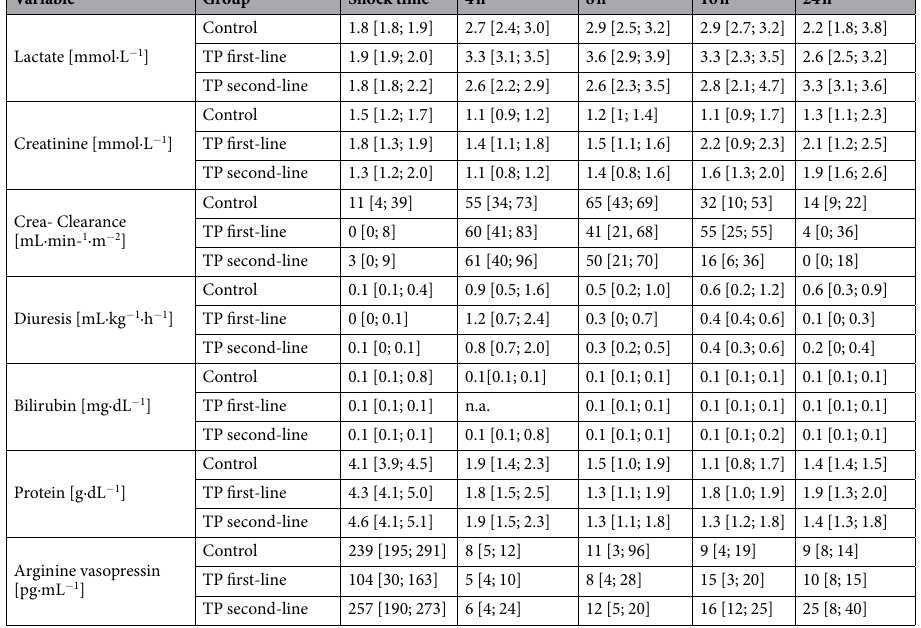
Table 3. Parameters of organ function of the study groups during the 24-hour interventional period. Values are presented as median [interquartile range]. Bilirubin, serum bilirubin concentration; Crea-Clearance, creatinine clearance; Creatinine, serum creatinine concentration; Protein, serum protein concentration; TP, Terlipressin .